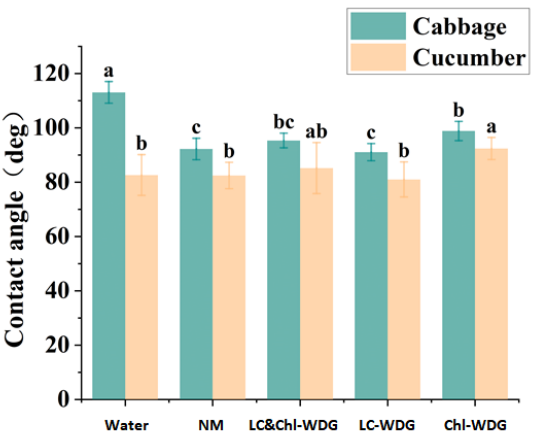
Figure 9. Contact angles for droplets of water, the nano-microcapsules containing lambda cyhalothrin and chlorantraniliprole (NM), LC-WDGs mixed with Chl-WDGs (LC and Chl-WDG), LC-WDG, and Chl-WDG on cucumber and cabbage leaf surfaces. The different letters above columns indicate significant differences among different treatments (one-way ANOVA, Duncan test, p < 0.05)